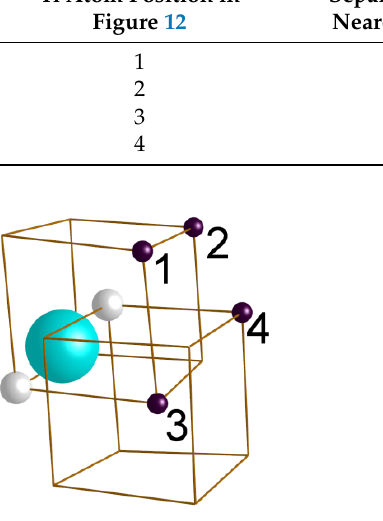
Figure 12. Symmetrically non-equivalent positions of a Ti atom with respect to a Y-V pair in bcc iron. The Y atom is marked with a blue sphere, and empty sites are indicated with smaller white spheres. The brown spheres represent Ti atoms located in positions numbered from 1 to 4, as referenced in